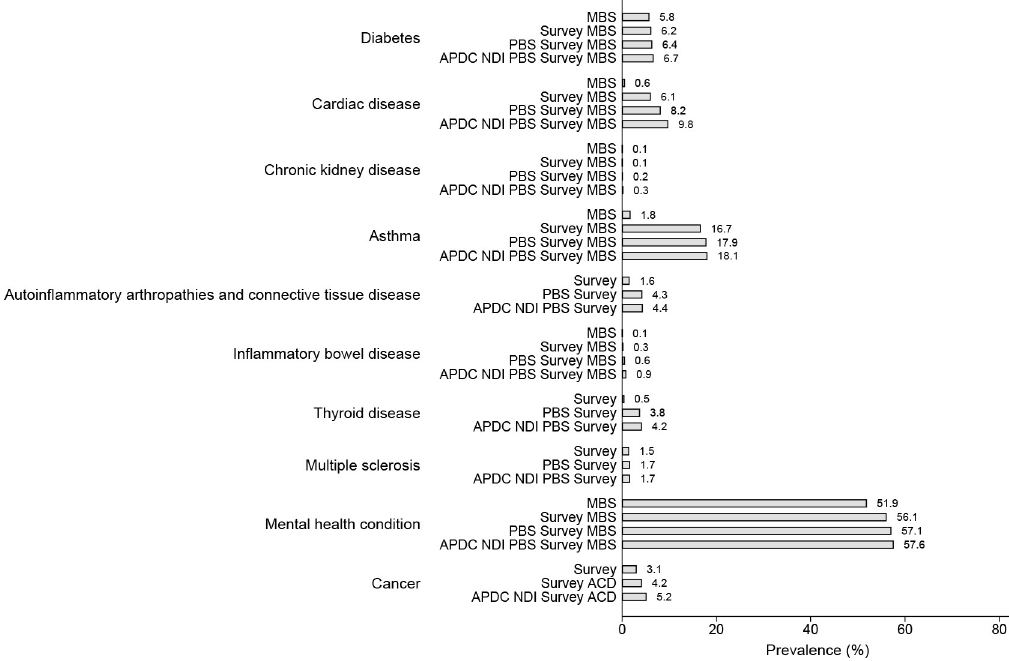
Fig 3. Prevalence of chronic conditions by June 2020 among Australian women aged 42–47 years (accounting for the progressive inclusion of additional data sources according to the typical timing of diagnosis and management for each